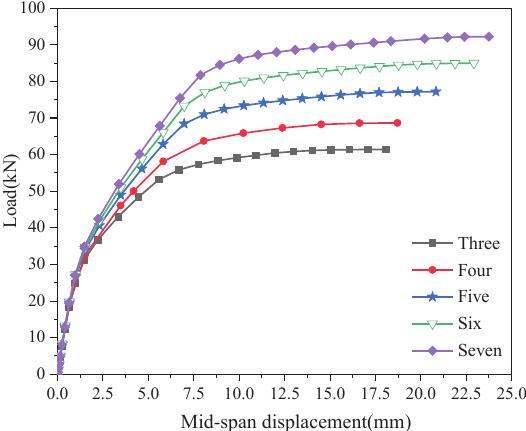
Figure 17. Load-mid-span displacement curves of composite slabs with different reinforcement ratio.